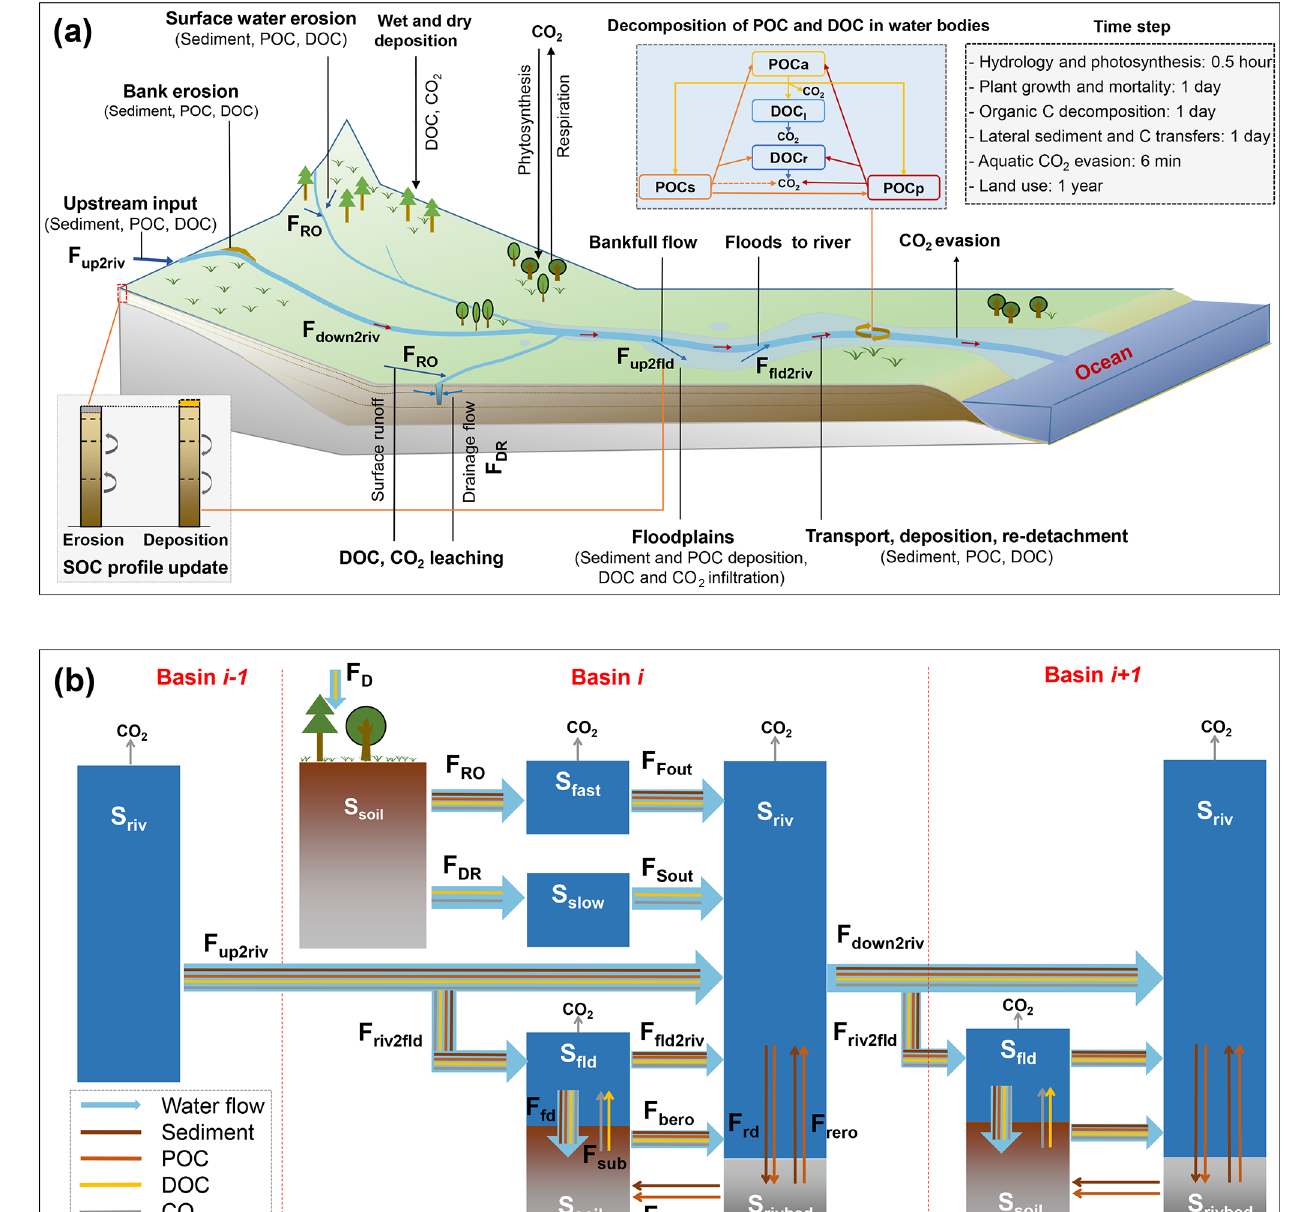
Figure 2. Simulated lateral transfer processes of water, sediment, and carbon (POC, DOC, and CO 2 ) in ORCHIDEE-C lateral (a) and a schematic plot for the reservoirs and flows of water, sediment, and carbon represented in the routing module of ORCHIDEE-C lateral (b) . S soil is the soil pool. S rivbed is the sediment (also POC) deposited on the riverbed. S fast , S slow , S riv , and S fld are the “fast”, “slow”, stream, and flooding water reservoir, respectively. F RO and F DR are the surface runoff and belowground drainage, respectively. F Fout and F Sout are the flows from the fast and slow reservoir to the stream reservoir, respectively. F up2riv and F down2riv are the upstream inputs and downstream outputs, respectively. F riv2fld is the output from the river stream to the flooding reservoir. F fld2riv is the return flow from the flooding reservoir to the stream reservoir. F bed2fld is the transformation from deposited sediment in a riverbed to floodplain soil. F bero is bank erosion. F rd and F rero are the deposition and re-detachment of sediment and POC in a river channel, respectively. F sub is the flux of DOC and CO 2 from floodplain soil (originating from the decomposition of submerged litter and soil carbon) to the overlying flooding water. F fd is the deposition of sediment and POC as well as the infiltration of water and DOC. F D is the wet and dry deposition of DOC from the atmosphere and plant canopy. DOC l and DOC r are the labile and refractory DOC pool, respectively. POC a , POC s , and POC p are the active, slow, and passive POC pool,